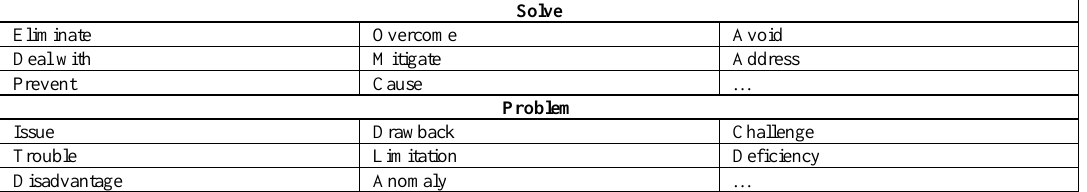
Table 2. Synonyms of “Solve problem” found within the considered pool of documents.